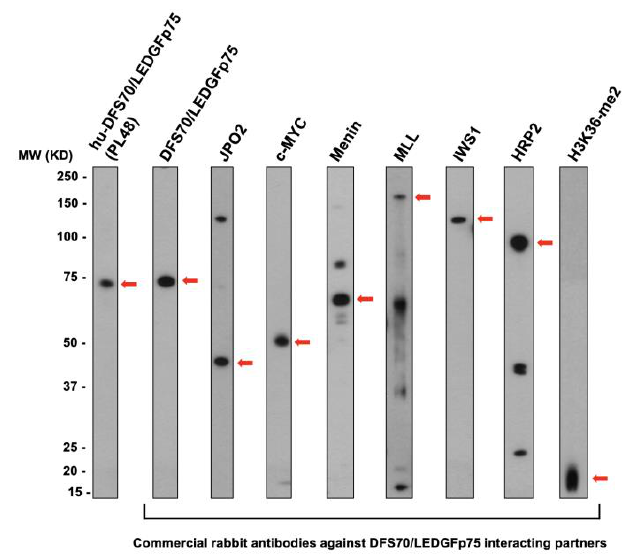
Figure 6. Immunoblots of selected DFS70/LEDGFp75 interacting partners. Total proteins from PC3-DR prostate cancer cells were used as substrates. Individual protein strips were incubated with commercially available rabbit antibodies against selected interacting partners of DFS70/LEDGFp75. Human anti-DFS70/LEDGFp75 serum PL48 was used as a positive control. Red arrows point to bands corresponding to the target proteins. Antibodies to Menin, MLL, and HRP2 reacted with additional bands considered non-specific or degradation products.